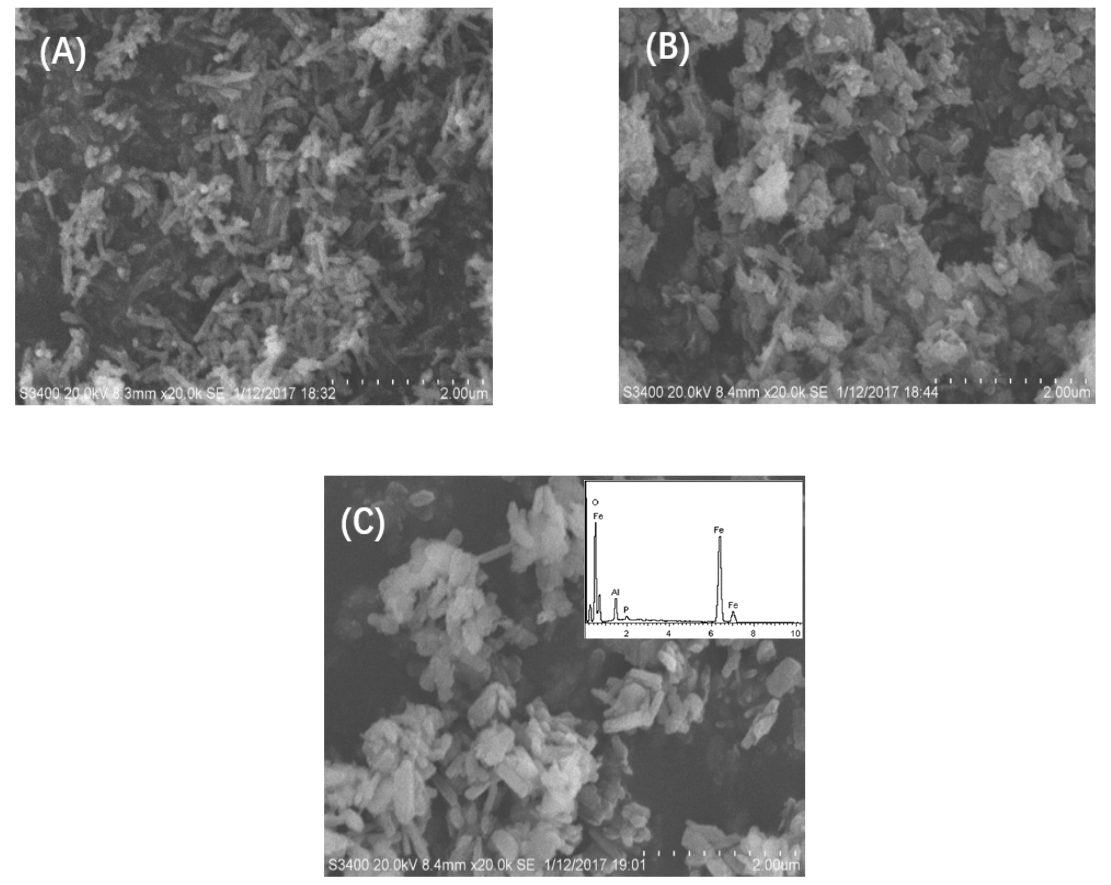
Figure 3. SEM images of catalysts prepared using different proportions: ( A ) γ -Al 2 O 3 /TiO 2 / γ -Fe 2 O 3 (1:0.5:1); ( B ) γ -Al 2 O 3 /TiO 2 / γ -Fe 2 O 3 (1:1:1); ( C ) γ -Al 2 O 3 /TiO 2 / γ -Fe 2 O 3 (1:2:1).